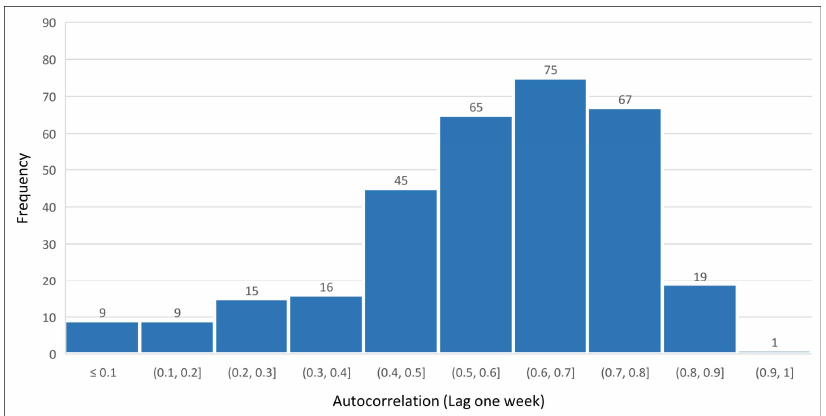
Figure 2. Autocorrelation frequency distribution over Period 1.